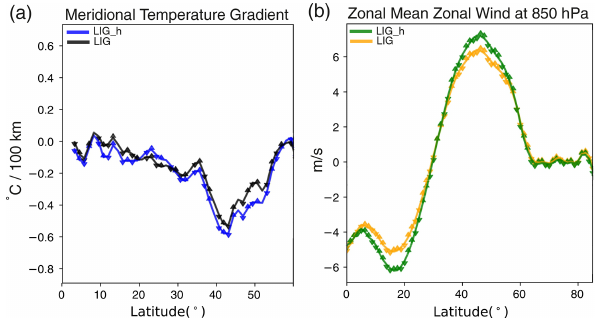
Figure 5. Mean surface air temperature (SAT) meridional temper- ature gradient for LIG_hosing (blue) and LIG (black) (a) as well as zonal mean zonal wind U at 850hPa for LIG_hosing (green) and LIG (orange) (b) for the North Atlantic (80–10 ◦ W) region. Solid lines are annual means, arrows are the standard error of the